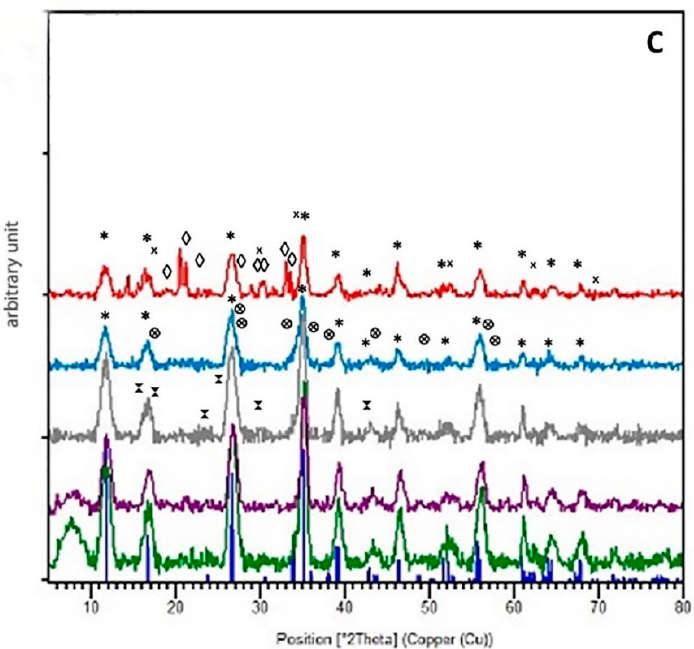
Figure 8. XRD diffractogram results of NBS samples with different oxygen scavengers: Oxyrase ( A ), No additives ( B ), and Sodium Thioglycolate ( C ). The dark blue lines denote the akaganeite reference pattern. ( A ) XRD patterns for Oxyrase solution from top to bottom: 0.625 mL/L, 1.250 mL/L, 1.875 mL/L, and abiotic control at 0.625 mL/L. ( B ) From top to bottom: no additives, abiotic control, pre-treatment Akaganeite. ( C ) XRD patterns for sodium thiosulfate from top to bottom: 250 mg/L, 250 mg/L, 500 mg/L, 1000 mg/L, abiotic control at 500 mg/L. Peaks associated with specific compound phases are indicated the following symbols: Akaganeite is indicated with [ * ], vivianite is with [ ◊ ], Iron Sulphide with [•], Iron (III) Hydroxide Sulphate with [ ■ ], Iron Phosphate(V) Oxide with [ ⦻ ], magnetite with [x], and Tetraphosphorus (V) Oxide with [ ⧗ ].